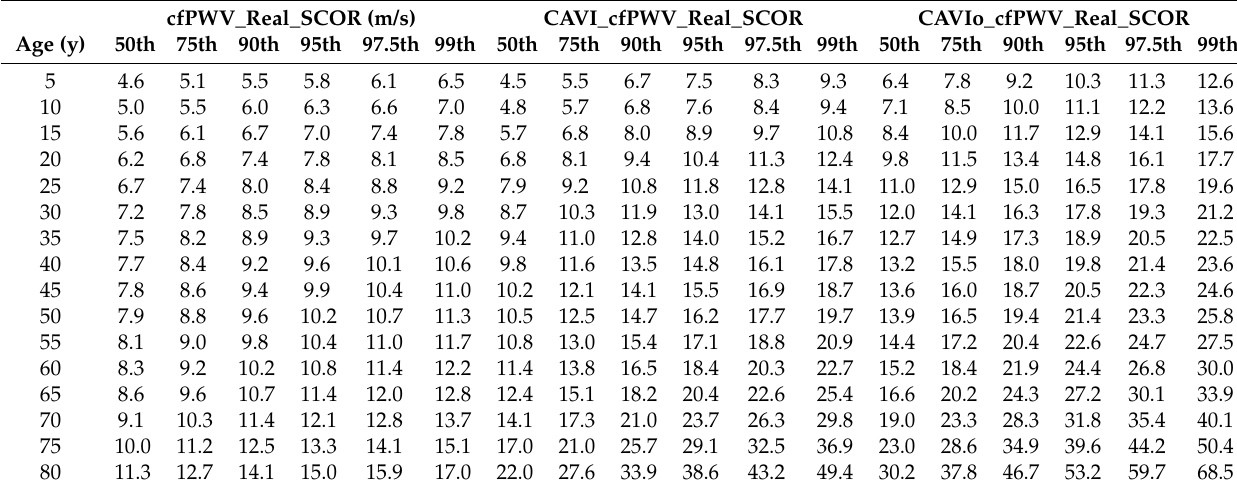
Table 8. cfPWV _Real_SCOR levels and related parameters (CAVI and CAVIo) reference intervals: All.